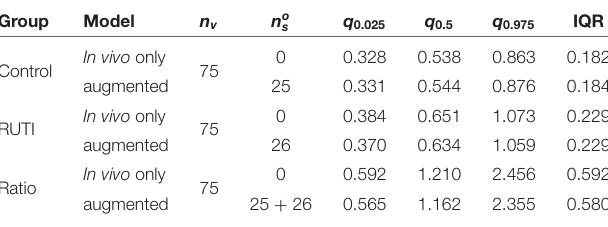
TABLE 3 | Summary statistics (2.5, 50, and 97.5% quantiles) and IQR of the posterior odds of the Control and RUTI groups from the in vivo ( n v ) and augmented trials after adding the optimal size batch of virtual patients, ( n o s